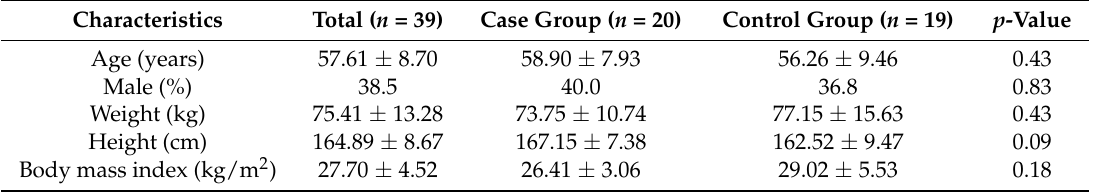
Table 1. Baseline lifestyle and anthropometric characteristics of the study